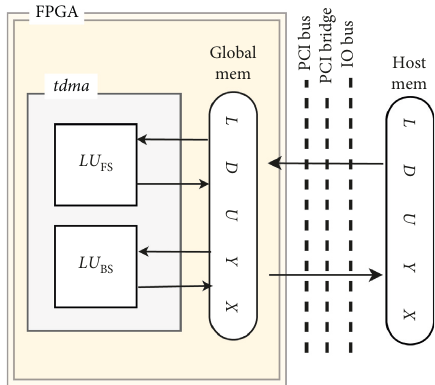
Figure 2: The FPGA TDMA OpenCL kernel tdma , with the ex- ecution path and data dependencies shown. The tdma executes as a single WI kernel.